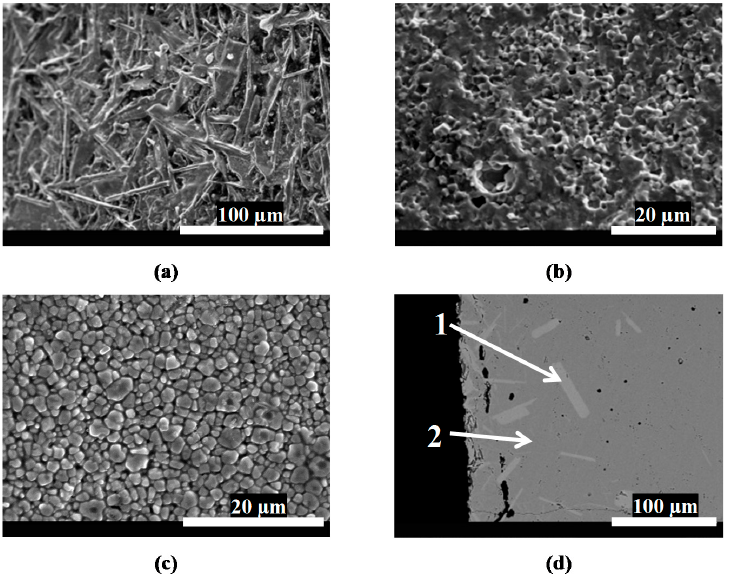
Figure 9. SEM micrographs of BCZN ceramics ( S2a ): ( a ) of a surface; ( b ) of a fractured surface; ( c ) of a grain boundary; and ( d ) of a longitudinally polished section.